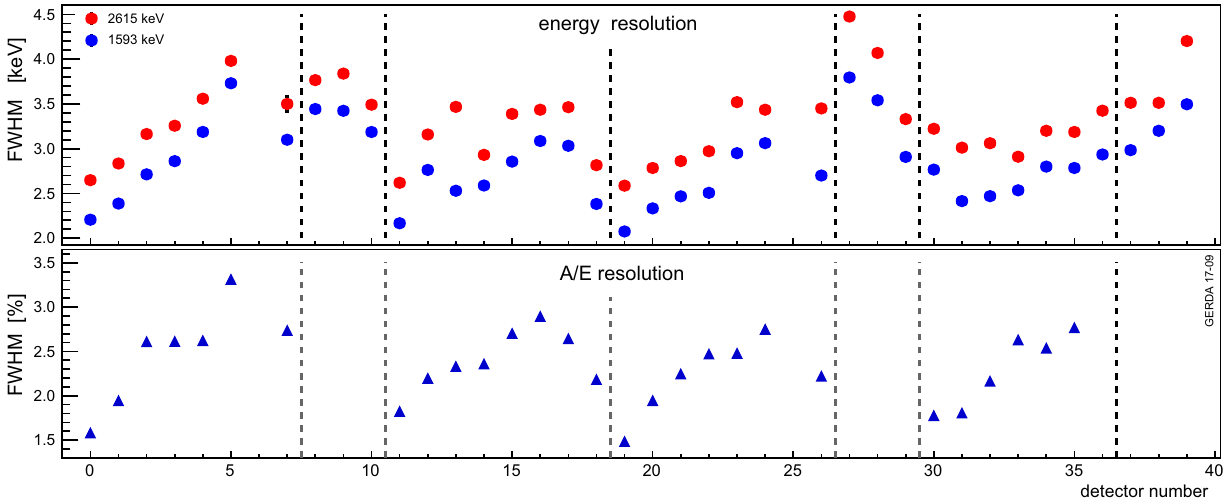
Fig. 21 FWHM energy resolutions (top) of the 2615keV line and its DEP at 1593keV, and A/E resolutions (bottom) of individual Ge detectors deduced from the DEP [37]. The dashed lines separate the 7 detector strings; within each string the detector number increases from top to bottom detector